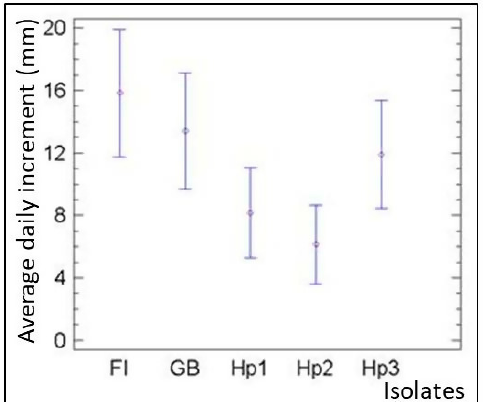
Figure 4. Average daily mycelium elongation of P. gigantea isolates: FI = Finnish, GB = British; Hp1, Hp2, Hp3 = Polish H. parviporum isolates (by Ż ó ł ciak et al. [62]).